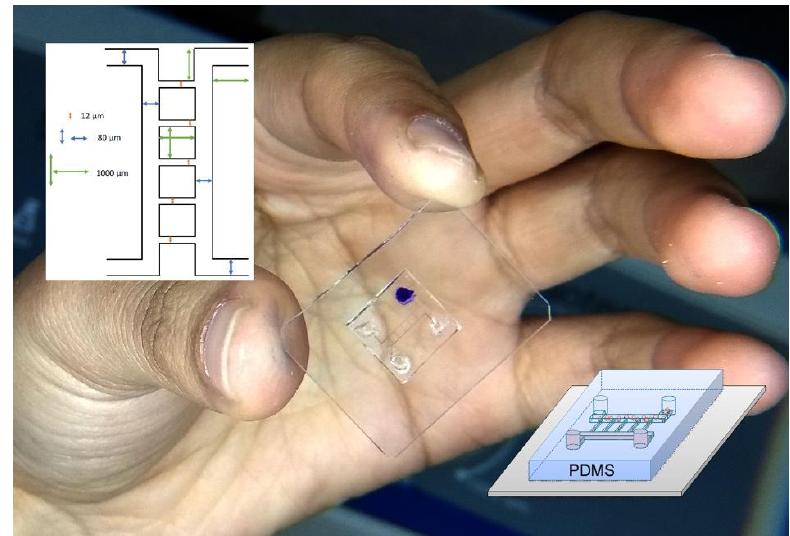
Figure 8. PDMS microchip device. The microchip consists of a poly(dimethyl siloxane) (PDMS) microfluidic device on the top of a glass substrate. This structure supports an alternative low-cost fabrication method with which a low-power visible ablation is possible. The insets show a schematic view of our microchip.